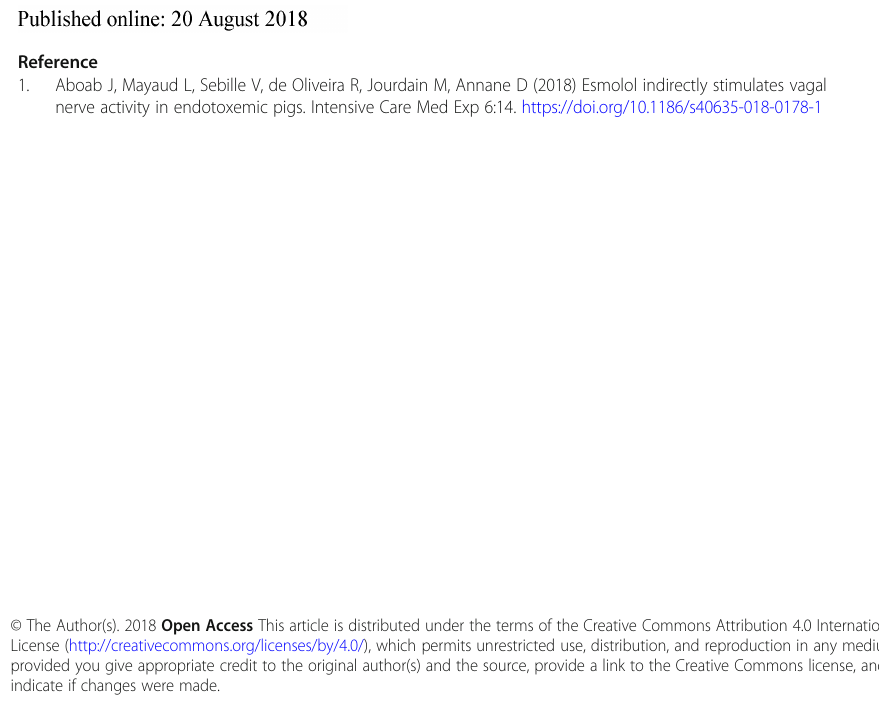
Fig. 5: The last graph of the first line, titled LF v, should be HFv The last bottom graphs, titled SDnn and RR nn, should be HF (instead of SDnn) and LF/HF (instead of RRnn) Fig. 6: The title of the last graph bottom line is LF/HF (instead of HF/LF). The original article [1] has been updated to reflect